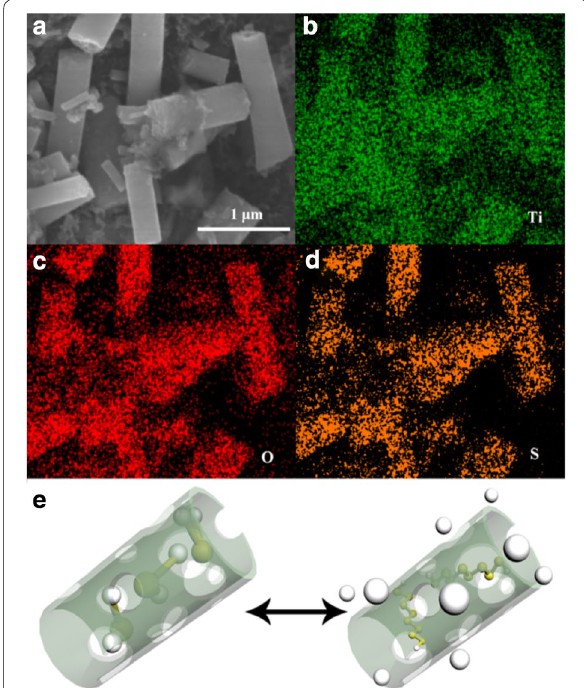
Figure 7 a SEM and b – d elemental mapping results of TiO 2 /S cathode cycled 200 times at 0.1 C rate between 1.5 and 3.0 V, e schematic diagram of mutual transformation between S 8 and Li 2 S at the mesoporous TiO 2 nanofibers structure